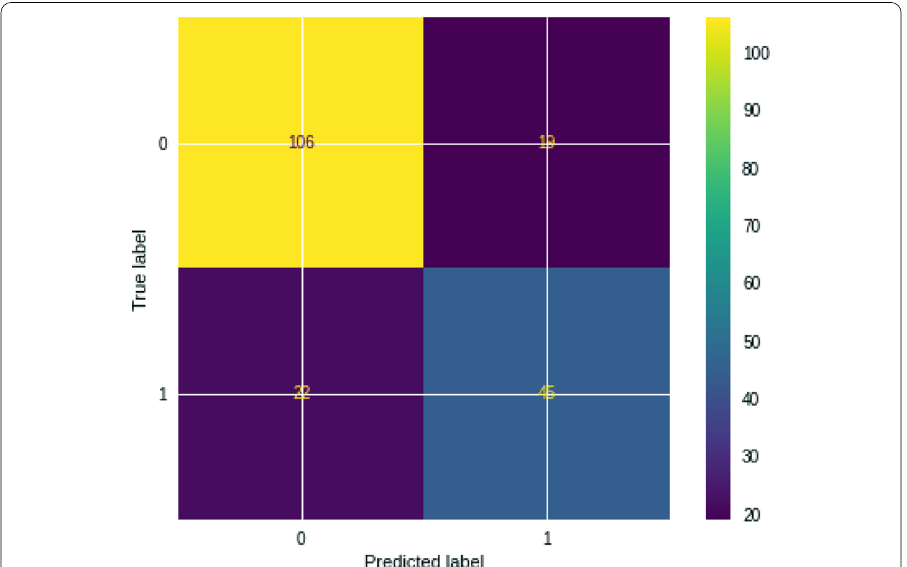
Fig. 16 Output: Confusion matrix of the proposed algorithm applied to the